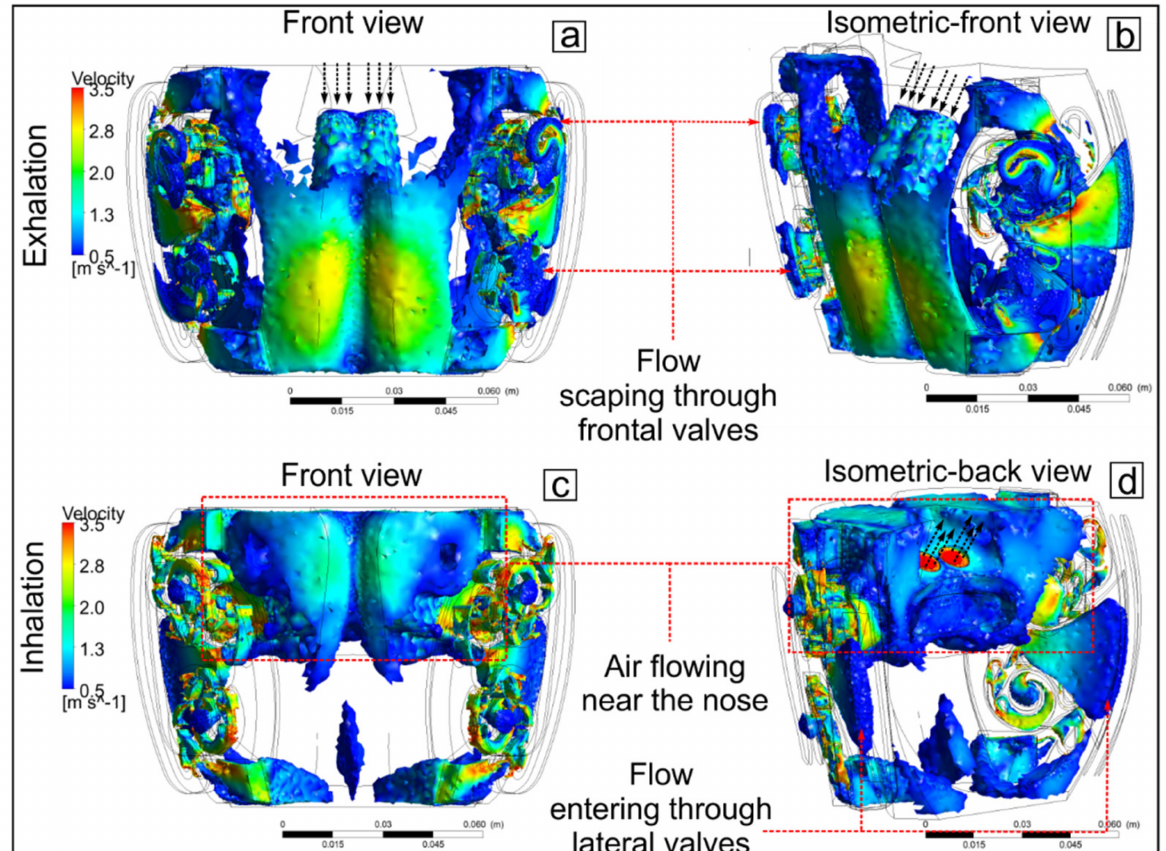
Figure 10. Iso-volume of air velocity into the mask. ( a , b ) exhalation event; ( c , d ) inhalation